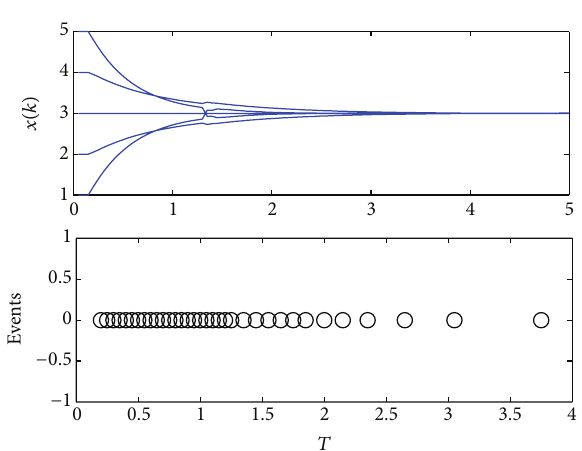
Figure 7: Protocol (26) for 𝑝 = 0.9 and 𝜏 = 0.1